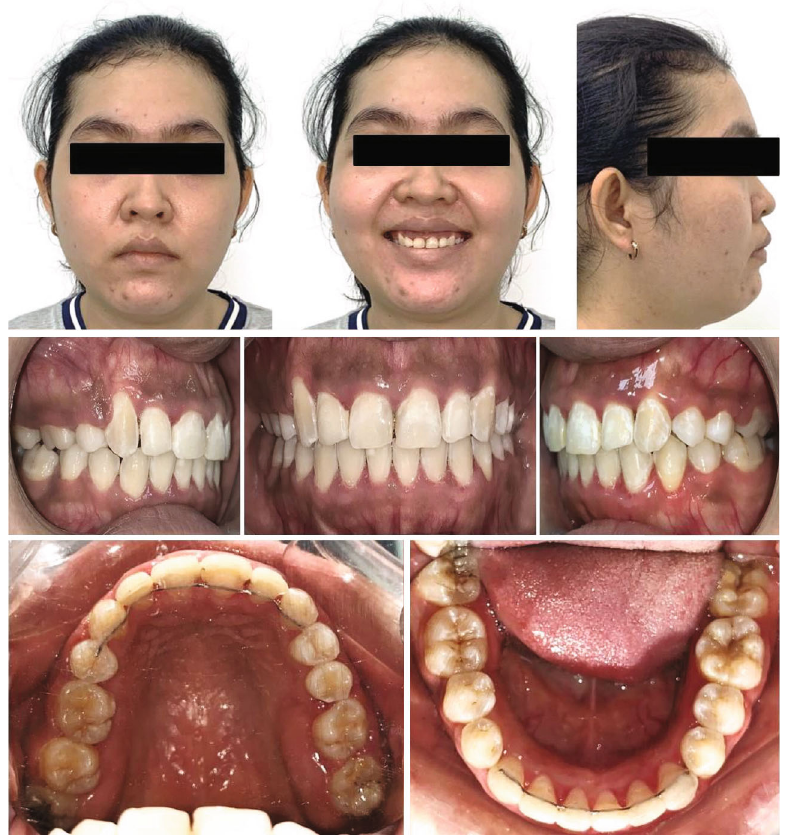
Figure 7: Posttreatment extraoral and intraoral pictures prior to gingivectomy.